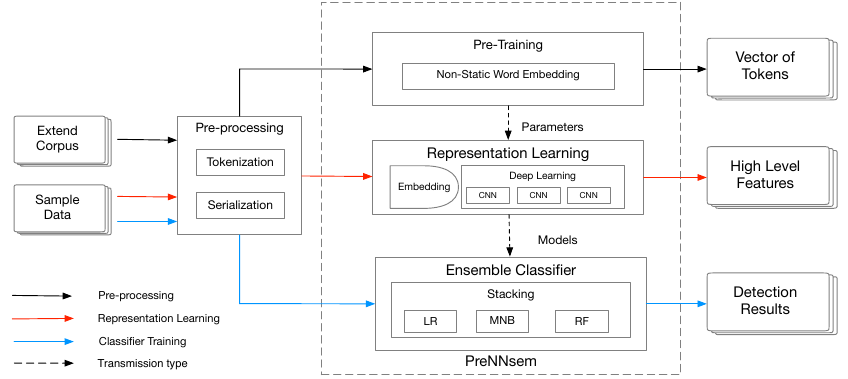
Figure 1. Overview of the proposed PreNNsem (pre-training for vector representation, neural networks for automated feature extraction, and ensemble learning for classification)